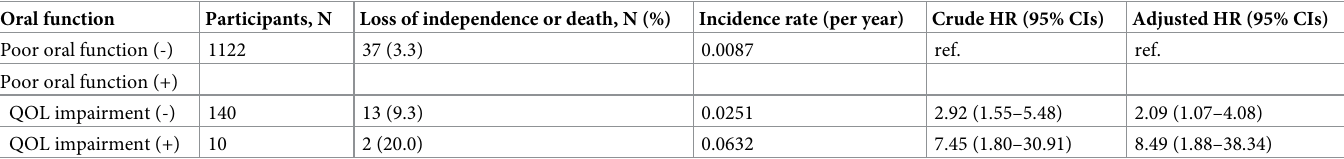
Table 3. Association between poor oral function with QOL impairment due to dysphagia and loss of independence or death. Oral